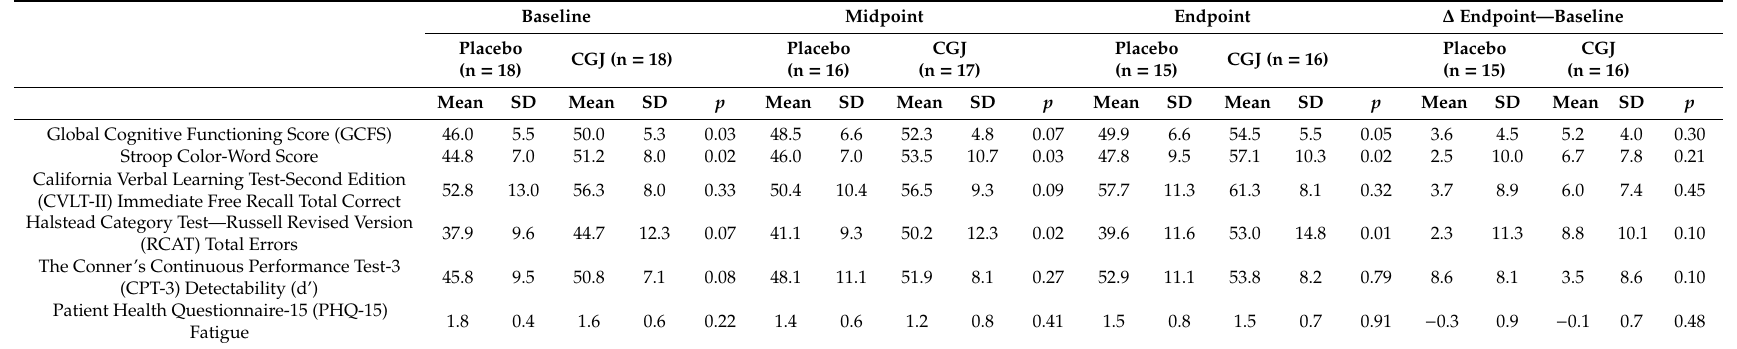
Table 3. Mean demographically-corrected neuropsychological test (T scores) and fatigue scores across all timepoints by randomization group. (T-score range: 0–100, with higher values indicating better performance; PHQ-15 fatigue score range: 0–2, with higher values indicating more severe fatigue) CGJ—Concord grape juice; SD—standard